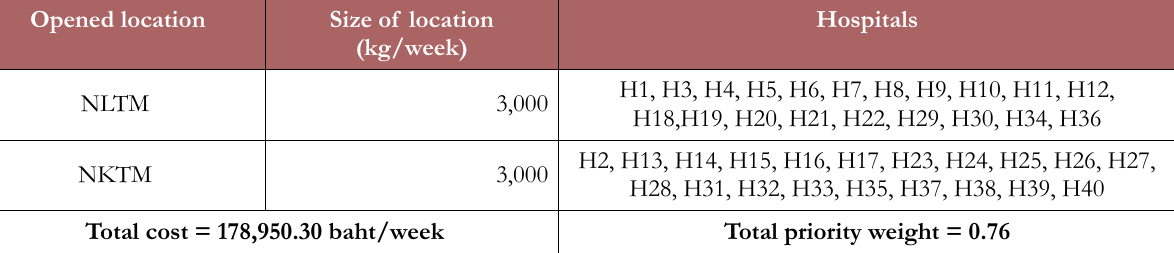
Table 9. Optimal solution of HFGP